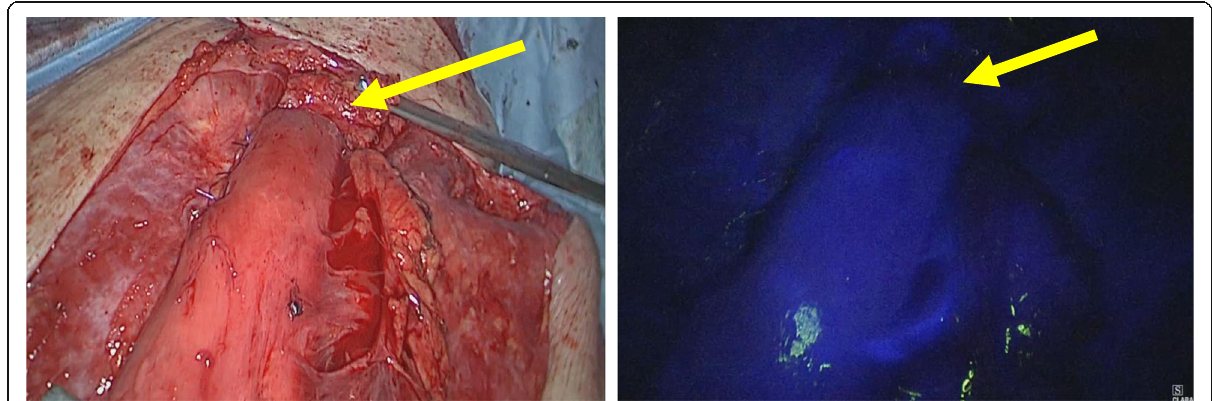
Fig. 3 Intraoperative image. ICG 5 mg was injected after division of the right gastroepiploic artery and right gastric artery in addition to the duodenum 1 cm distal to the pylorus ring. There is sufficient inflow of ICG (blue indicates blood flow) from the esophagogastric anastomosis (yellow arrow) to the proximal gastric tube. ICG, indocyanine